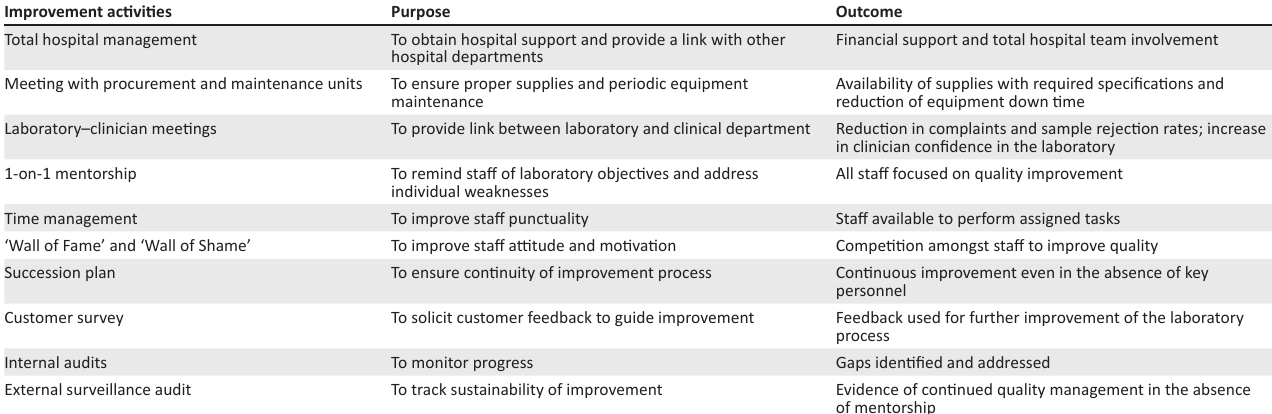
TABLE 2: Summary of improvement